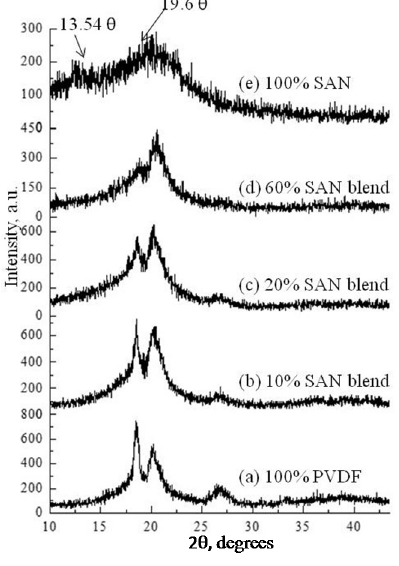
Figure 3. XRD of styrene ‐ acrylonitrile ‐ blended PVDF membranes. Figure 3. X-ray diffraction of styrene-acrylonitrile-blended PVDF